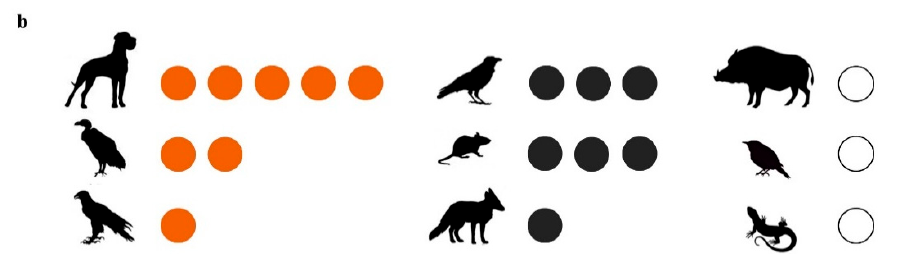
Figure 3. Comparison between the national poisoned fauna database (“Ant í doto Programme”) and the field experiment results according to the different species groups and study areas. ( a ) Frequency of occurrence of individuals in each group recorded in the “Ant í doto Programme” (orange bars) compared to the percentage of baits consumed during the field experiment per group (from left to right: wild carnivores, domestic carnivores, suids, small mammals, corvids, vultures, other raptors, other birds, and reptiles). Brackets indicate the total number of poisoned individuals in the database and the estimated total number of different individuals that consumed baits (see the text for details). The pair-wise χ 2 tests results are shown whenever we detected significant differences between both data sources ( p < 0.05). ( b ) Number of study areas in which each group was over- (orange dots) or underrepresented (black dots) in the national database compared to the results of experimental baits. White dots denote the groups for which we detected no significant differences between data sources.